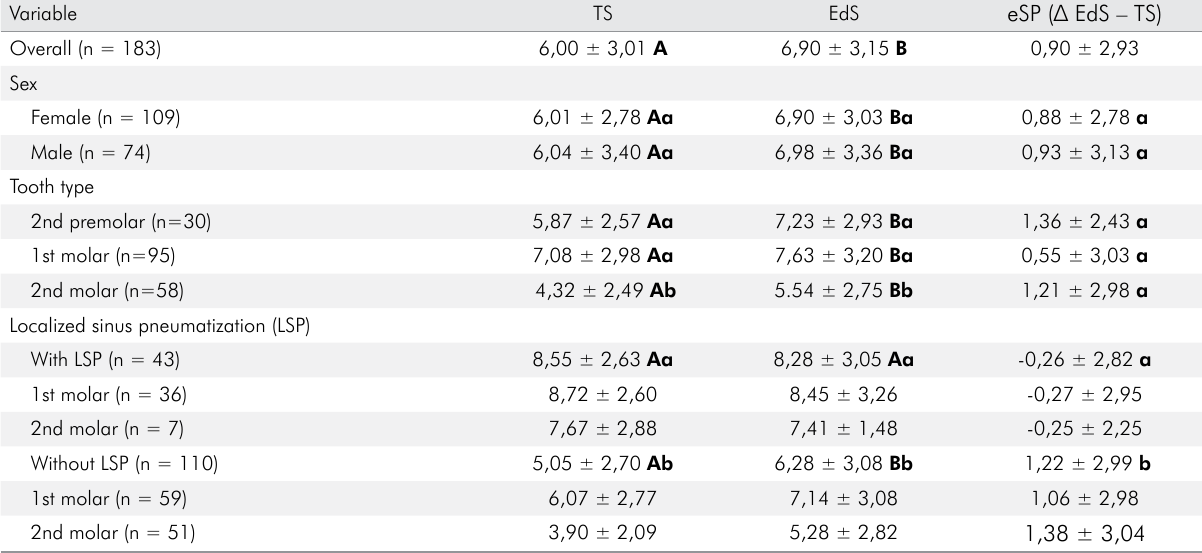
Table 1. Sinus height (SH) measurements (mm) according to overall sample, tooth type, localized sinus pneumatization and sex. Variable